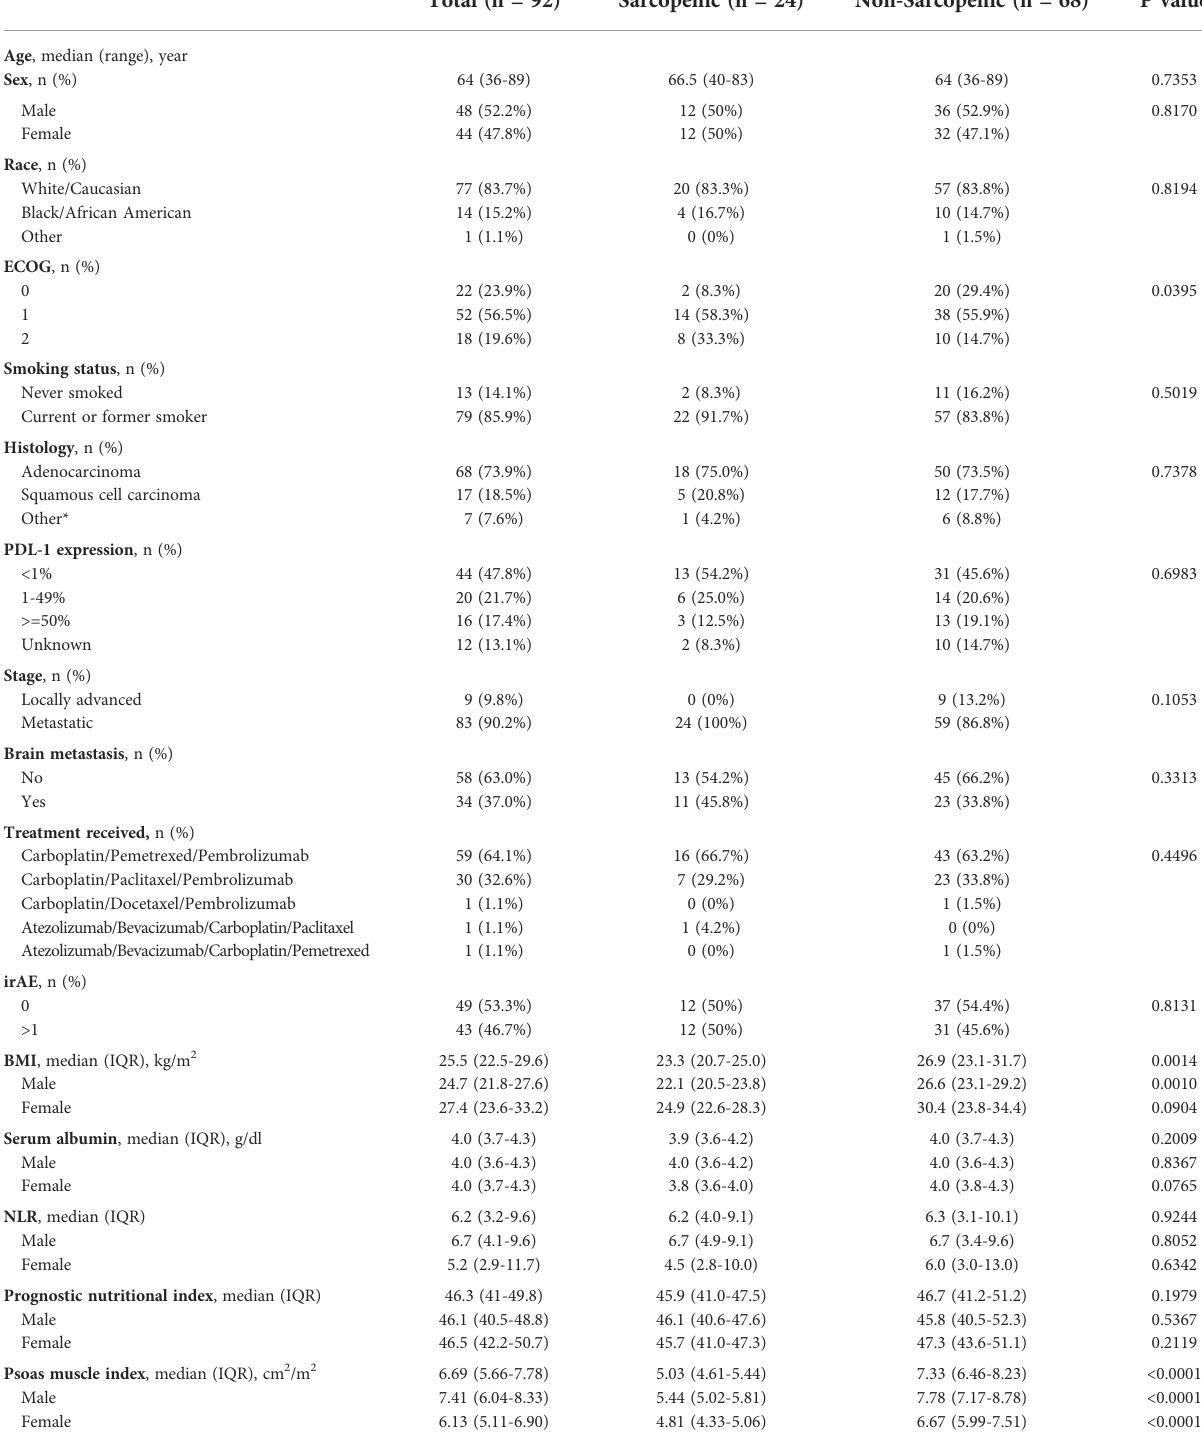
TABLE 1 Baseline characteristics strati fi ed by sarcopenia